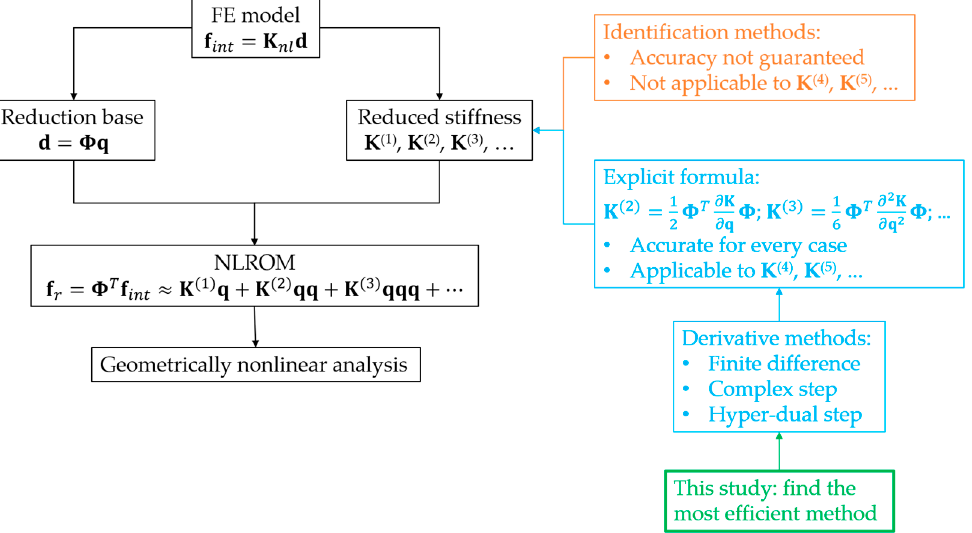
Figure 1. Fundamental of non-intrusive NLROM and role of this study.